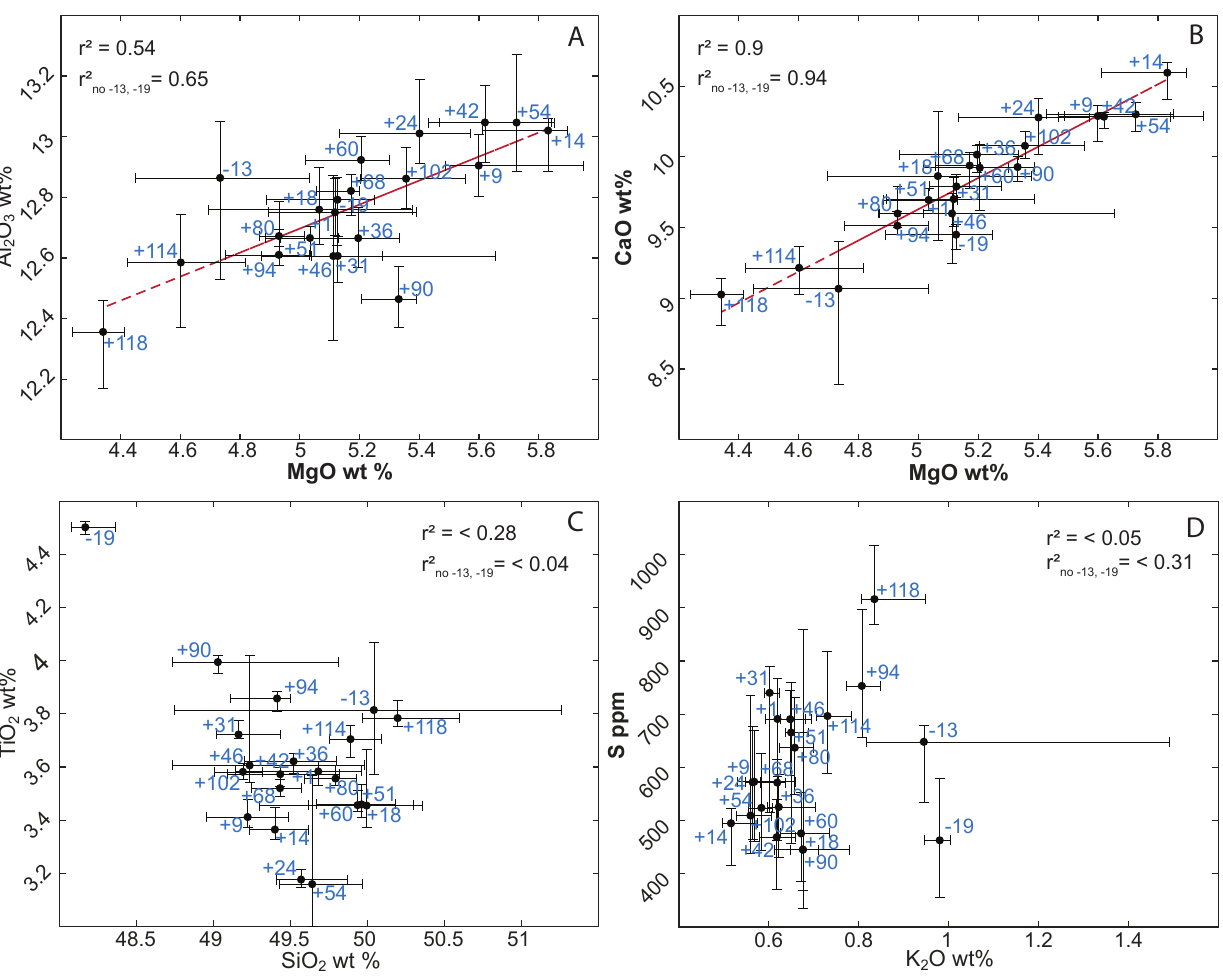
Figure 8: Major element crossplots. Each sample is labelled with ash number, with a dot showing median value and crosses indicating 25 and 75 quartile for X- and Y-axes. Red lines show linear regression for the median values, with the r 2 value noted both for all ashes, and for only the positive series. Data in Table S1, Supplementary